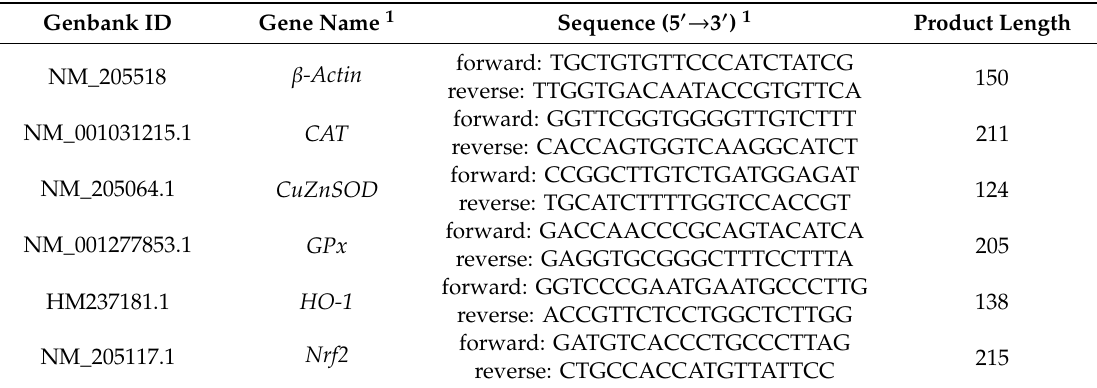
Table 2. Primers Used for Real-Time PCR (Experiment